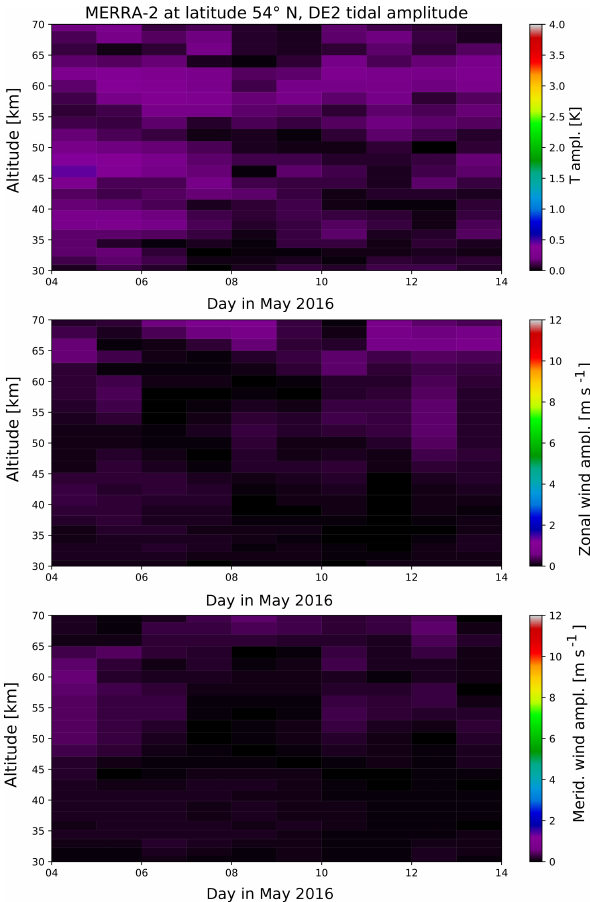
Figure A7. DE1 amplitude in temperature, zonal and meridional wind from global MERRA-2 fields at the latitude of 54 ◦ N.